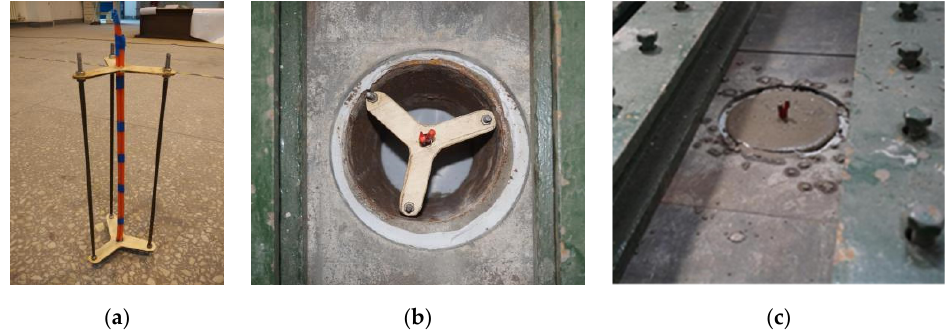
Figure 3. Schematic diagram of the charge structure in the model test samples: ( a ) detonating cords fixed in the wooden centering stent; ( b ) wooden centering stent in the model samples; ( c ) the pouring of quick-drying materials.